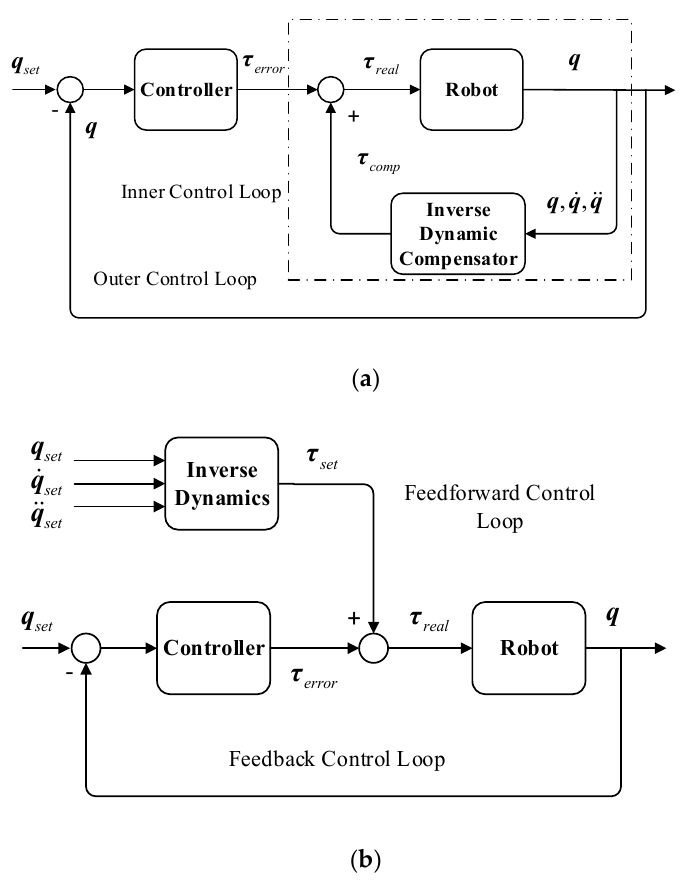
Figure 1. Model-based control structure. ( a ) dynamic feedback compensation; ( b ) dynamic feedforward.